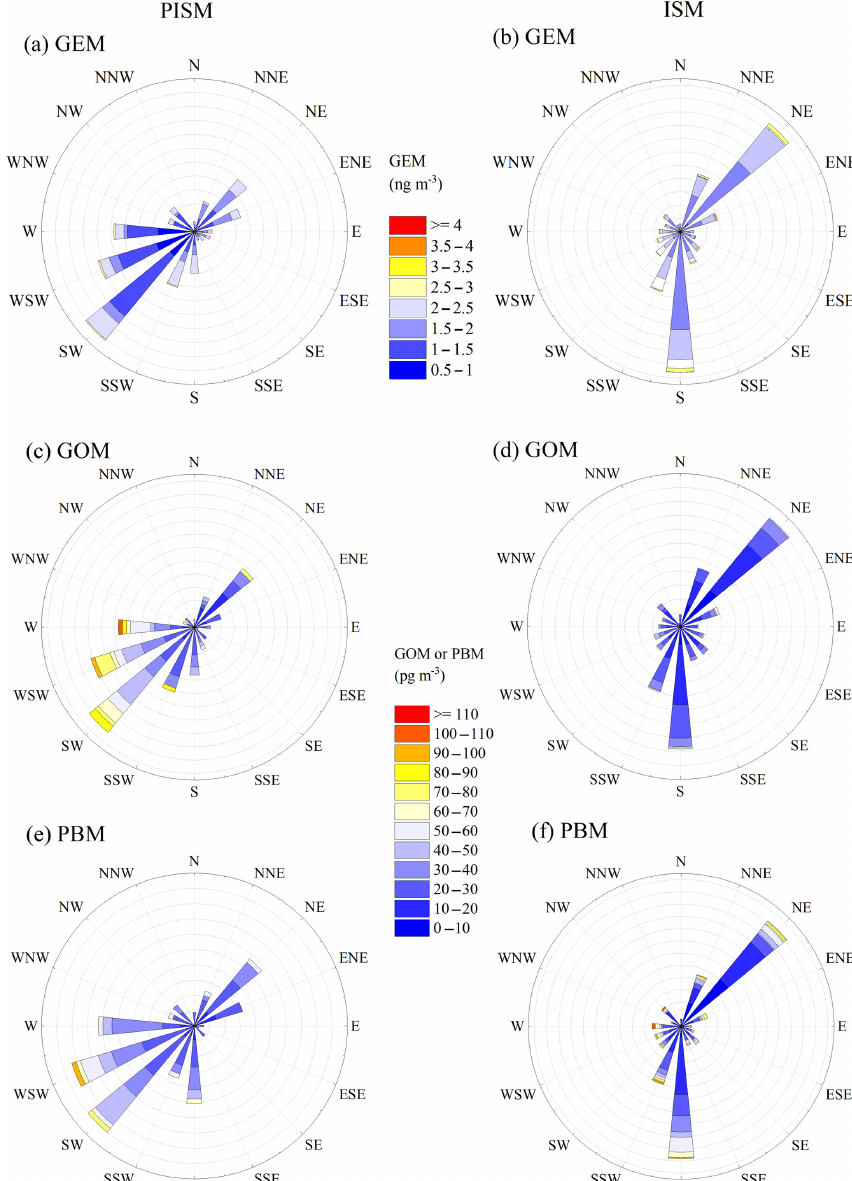
Figure 4. Concentration roses of GEM, GOM and PBM from different wind directions. The length of each spoke describes the frequency of flow from the corresponding